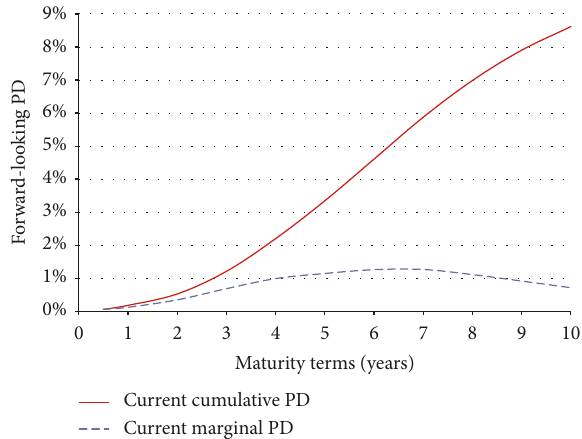
Figure 7: Goodyear Company default risk structure: current PD